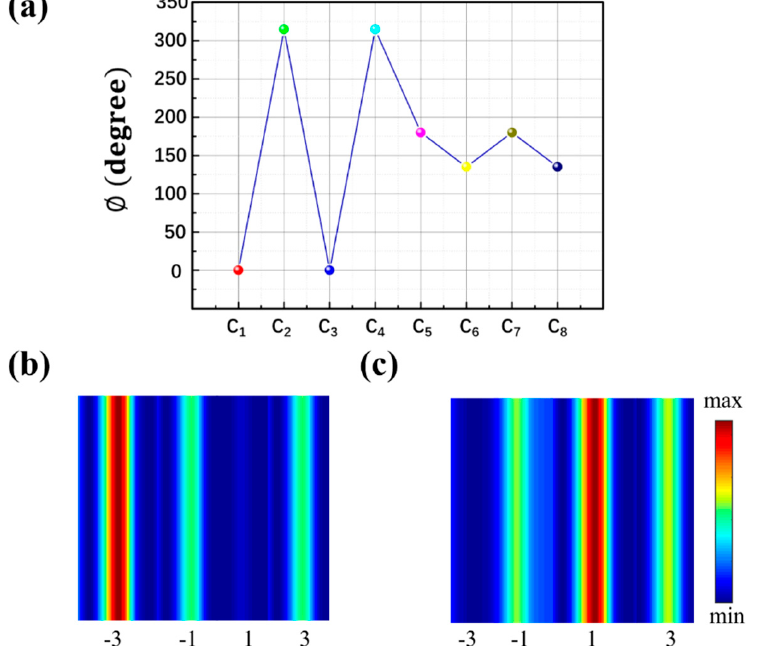
and the electric field intensity of the +1 diffraction order is almost zero. It can be seen from Figure 4c that the electric field intensity of the +1 diffraction order is the strongest, while the electric field intensity of − 1 and +3 diffraction orders are almost half that of the +1 diffraction order, respectively, and the electric field intensity of the − 3 diffraction order is almost zero. Combining Figure 4b,c, four beams of different polarization states are simultaneously generated by the designed metasurface under the RHCP incidence. Additionally, the four different polarization states are | H (cid:105) + | V (cid:105) ( − 3 diffraction order), | H (cid:105) ( − 1 diffraction order), | H (cid:105) − | V (cid:105) (+1 diffraction order), and | V (cid:105) (+3 diffraction order), respectively, which is consistent with the theoretical calculation result of Equation (9).